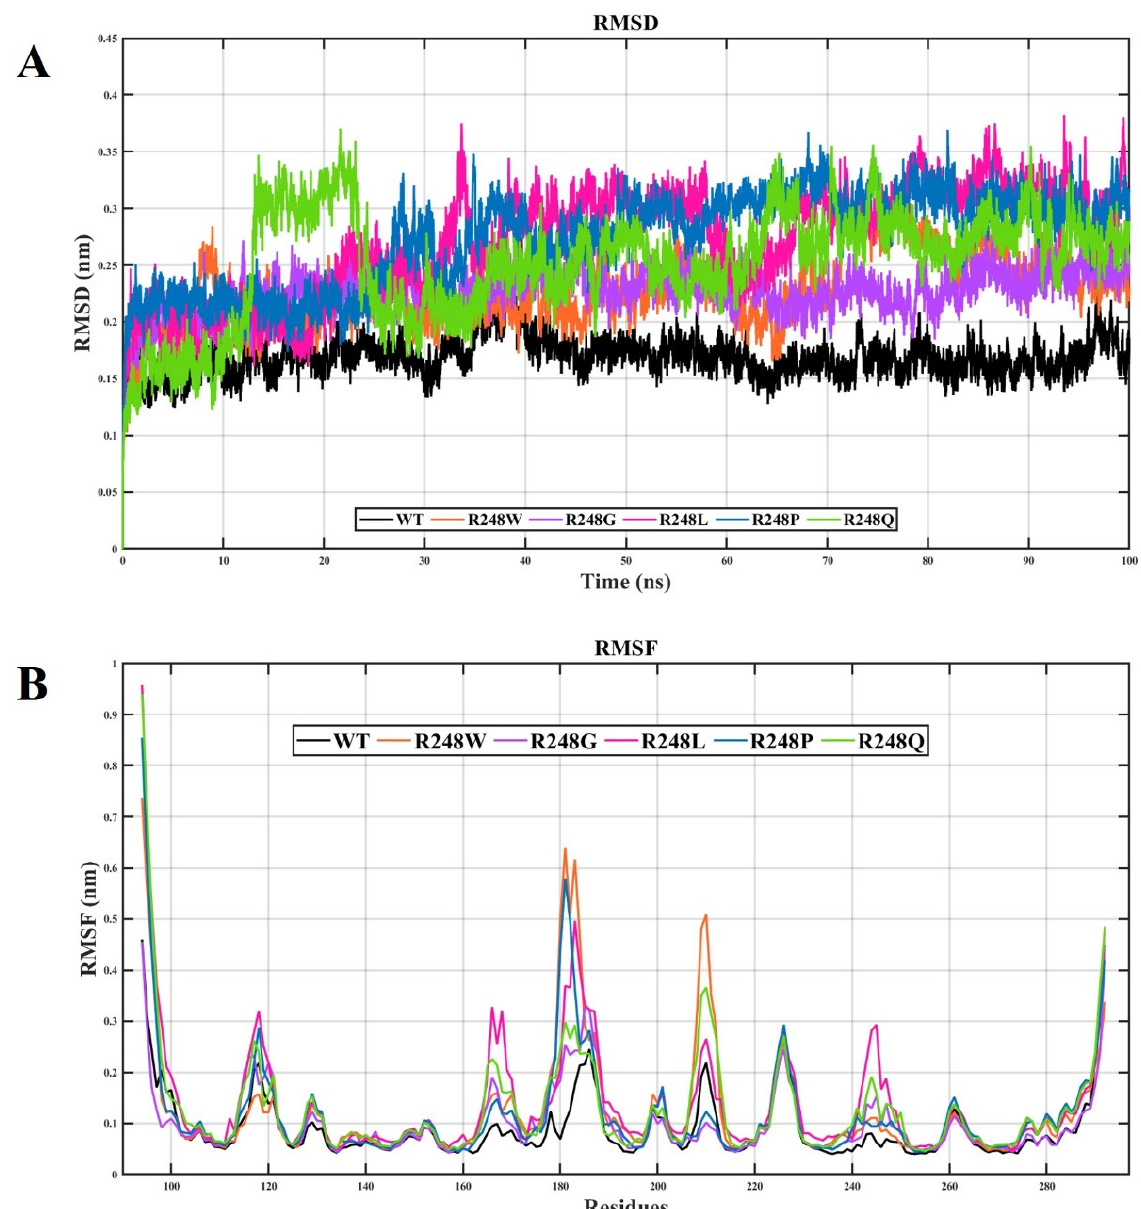
Figure 2. ( A ) RMSD plot of the wt-p53–DNA complex and R248 mutant-p53–DNA complexes. The X and Y axes denote time (ns) and RMSD (nm), respectively. ( B ) RMSF plot of the wt-p53–DNA complex and R248 mutant-p53–DNA complexes. The X and Y axes denote residues and RMSF (nm), respectively. Color representation is as follows: black (Wt-p53–DNA complex), orange (R248W mutant-p53–DNA complex), violet (R248G mutant-p53–DNA complex), pink (R248L mutant-p53–DNA complex), blue (R248P mutant-p53–DNA complex), and green (mutant-p53–DNA complex), respectively. We used Rg to quantify and characterize the compactness of wt-p53–DNA and mutant- p53–DNA complexes. The wt-p53–DNA complex had an average Rg value of ~1.6939 during the 100 ns simulation. The average Rg values for mutant R248W, R248G, R248L, R248P, and R248Q mutant-p53–DNA complexes were ~1.6974, ~1.6975, ~1.7102, ~1.6982, and ~1.6993, respectively. The mutant-p53–DNA complexes obtained slightly increased Rg values compared to the wt-p53–DNA complex. An increased Rg value in mutant-p53–DNA complexes implies a decrease in complex structure compactness, suggesting increased flexibility and less stability in mutants than in the wt-p53–DNA complex. Further,